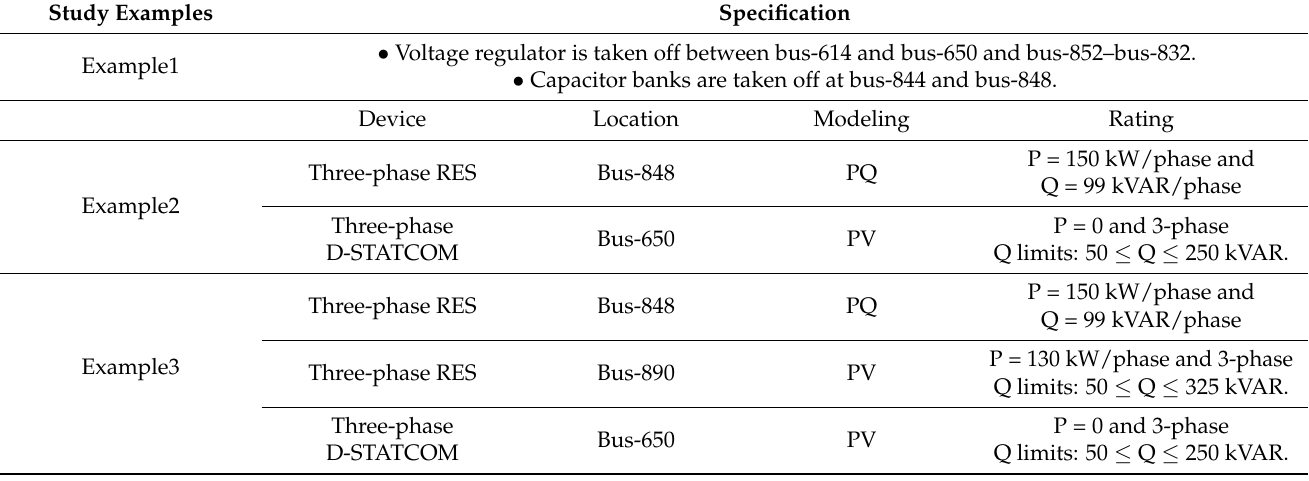
Table 9. Study examples of the IEEE-34 bus